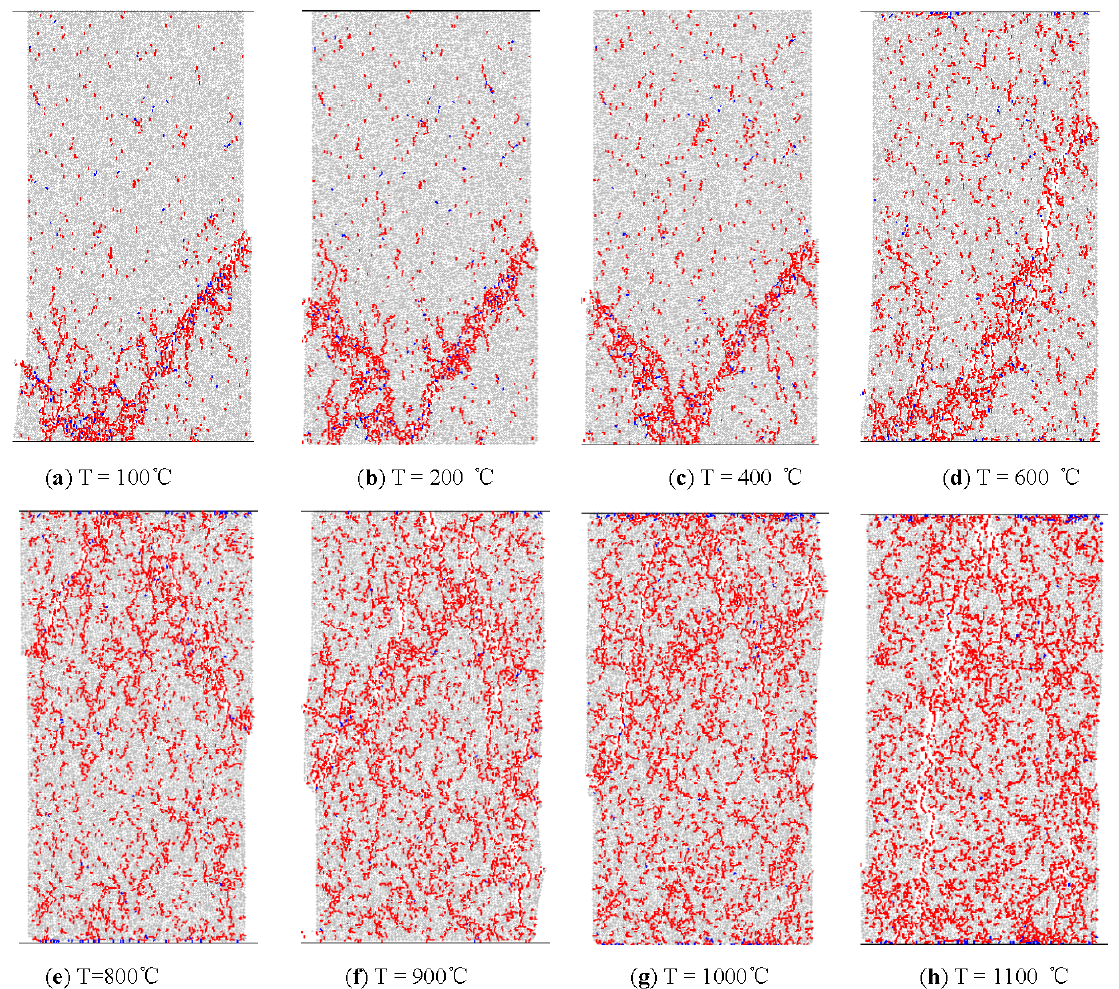
Figure 13. Numerical simulated results of ultimate failure mode of the numerical specimens after the heating treatment: ( a ) T = 100 °C; ( b ) T = 200 °C; ( c ) T = 400 °C; ( d ) T = 600 °C; ( e ) T = 800 °C; ( f ) T = 900 °C; ( g ) T = 1000 °C; and ( h ) T = 1100 °C.